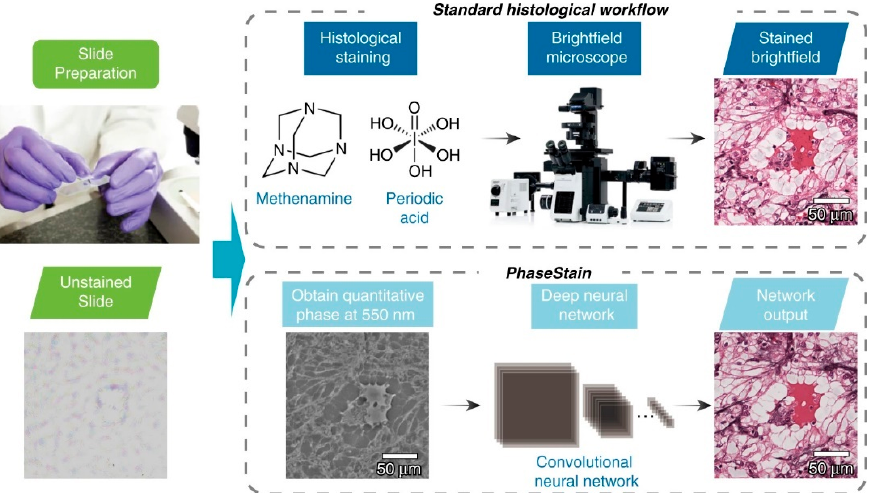
Figure 10. A quantitative phase image of a label-free specimen is virtually stained by a deep neural network, bypassing the standard histological staining procedure that is used as part of clinical pathology. Reproduced from [59] without modification under Creative Commons Attribution 4.0 License.